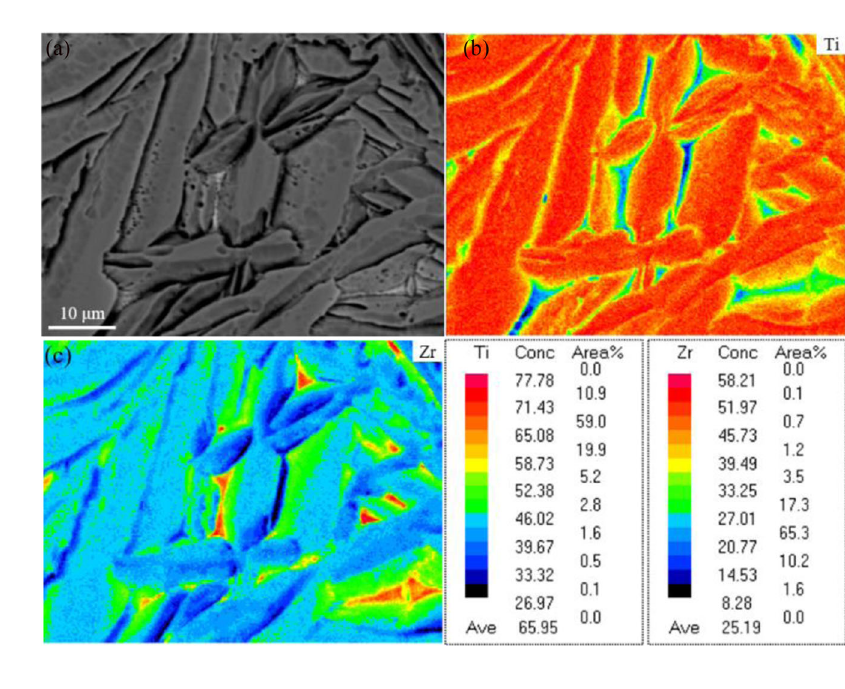
Fig. 5 Bright- fi eld image and selected electron diffraction pattern area of the Ti-45Zr alloy: ( a , b ) bright- fi eld image; diffraction pattern for the L1-L2 area; (L3-L4) HAADF diagram and corresponding transmission element plane distribution